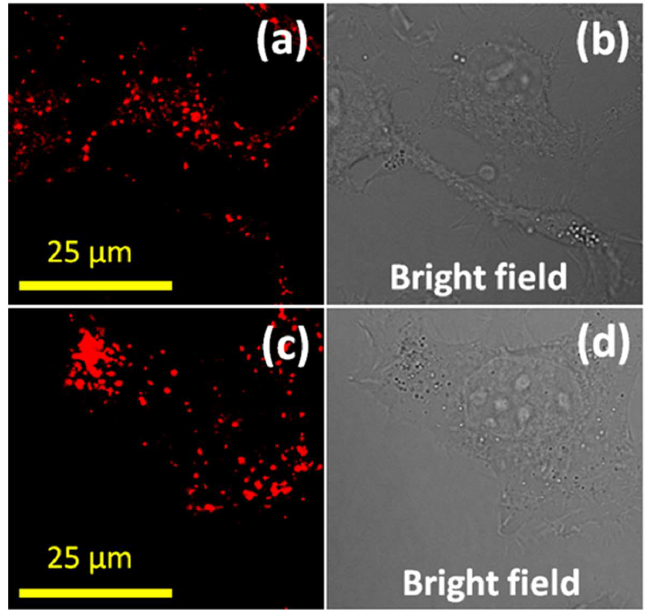
Figure 1. Fluorescence confocal microscopy images obtained from MO3.13 cells pre-incubated with probes 3a (200 nM) and 3b (200 nM) for 30 min. ( a – d ) represents probe 3a emission within the cells ( a ), bright field ( b ), probe 3b emission within the cells ( c ), and bright field ( d ). Probes 3a and 3b were excited with 561 nm laser line and the emission filter settings were set up to collect from 575 to750 nm range.